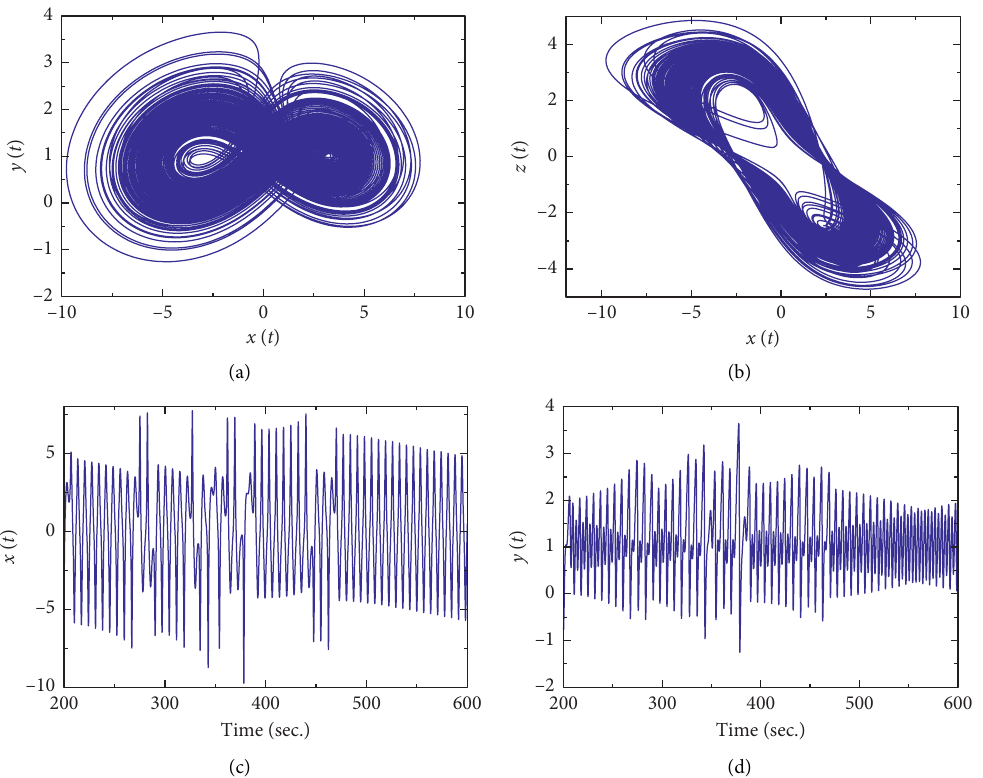
Figure 10: Phase diagrams and time series of system (6) with q Projected onto the x − z phase plane. (c) Time series of x . (d) Time series of y .